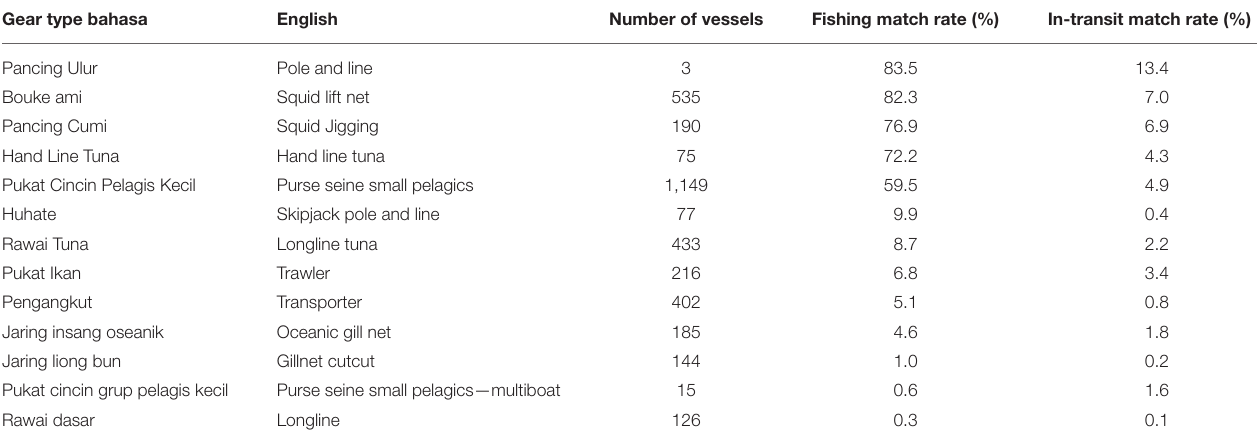
TABLE 2 | VMS/VBD match